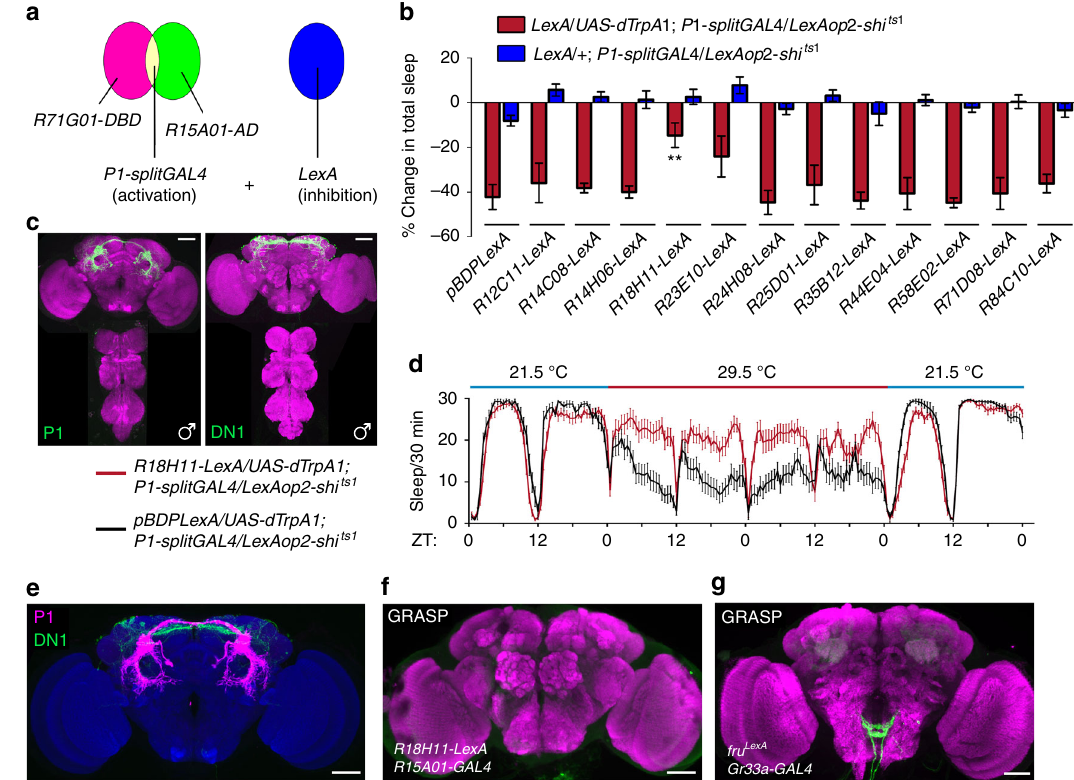
Fig. 5 P1 regulates male sleep through DN1 neurons. a Diagram for activating P1 neurons in the sex circuitry, and inhibiting subsets of neurons in the sleep circuitry. b Identi fi cation of R18H11-LexA DN1 circadian clock neurons as functionally downstream of P1 neurons. Blue bars indicate LexA inhibition alone, while red bars indicate P1 activation together with LexA inhibition. n = 24~56 for each. ** p < 0.01, Kruskal – Wallis non-parametric one-way ANOVA followed by post hoc Dunn ’ s correction. Error bars indicate SEM. c Expression pattern of P1-splitGAL4 and R18H11-LexA driving UAS-myrGFP and LexAop-myrGFP , respectively. d Detailed sleep pro fi les of P1 activation alone (in black line ) and P1 activation together with DN1 inhibition (in red line ). e Brain registration of P1 ( magenta ) and DN1 ( green ) neurons. f There is no GRASP signal between P1 and DN1 neurons. g GRASP signals between Gr33a-expressing neurons and fru M -expressing neurons as a positive control. Scale bars, 50 µ